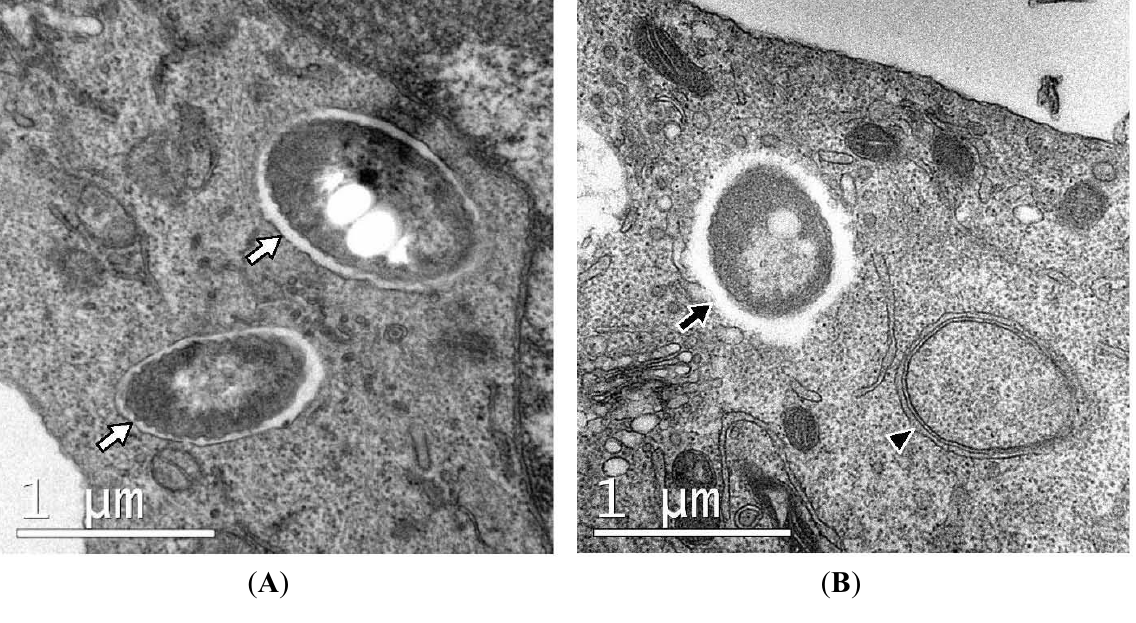
Figure 3. Ultrastructure of RAW macrophages expressing GFP-LC3 infected with B. pseudomallei . Intracellular bacteria are either sequestered within single-membrane phagosomes (white arrows in panel A ) or free in the cytosol (black arrow, panel B ). Single-membrane phagosomes can be clearly distinguished from double-membrane autophagosomes (arrowhead, panel B ).